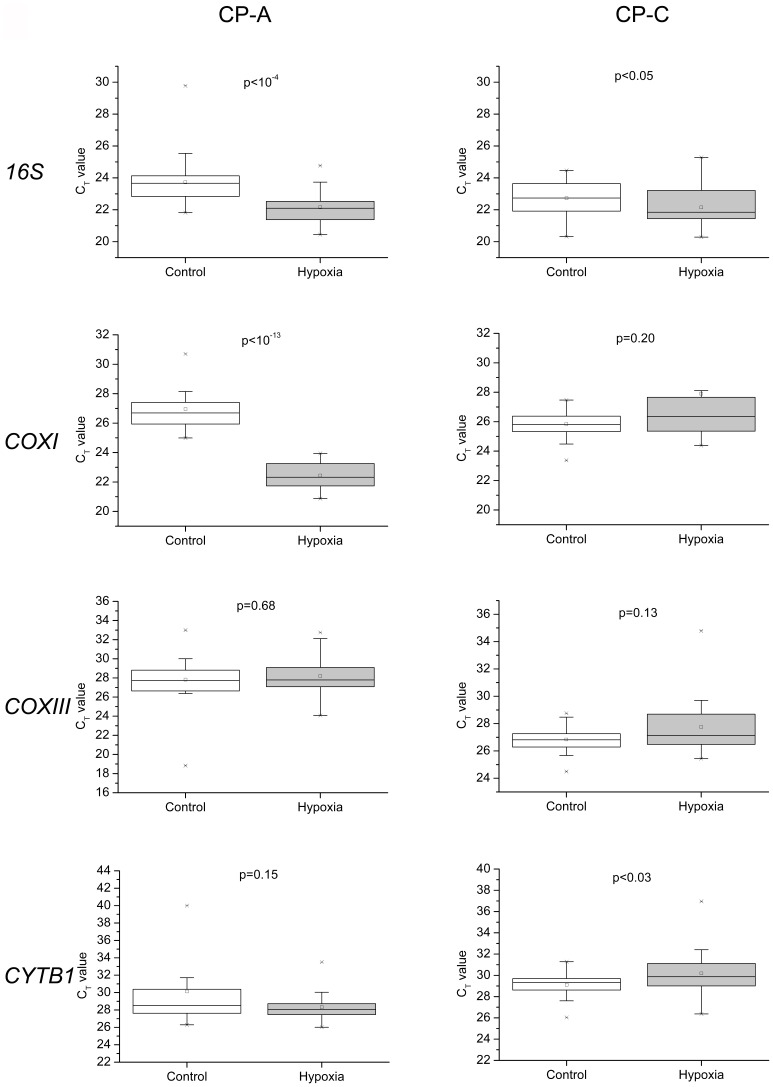
Expression levels of mitochondrially encoded genes (16s rRNA and COXI) in single control and hypoxia-treated CP-A and CP-C cells.Box plots of single-cell gene-expression levels and p-values associated with the differences between normoxic and hypoxic conditions in the two cell lines. The box chart shows following statistical values: Open square – mean, solid line – median, upper and lower box lines – the 75th and 25th percentiles, respectively, upper and lower whiskers – the 95th and 5th percentiles, respectively, x – maximal and minimal values.